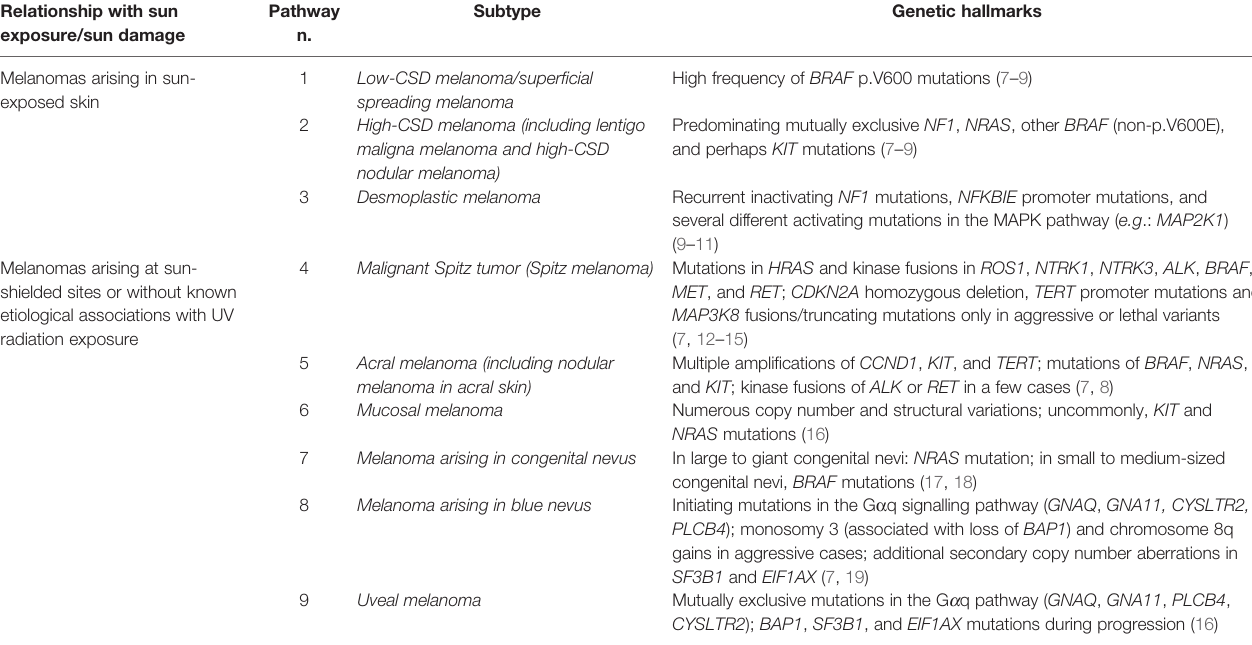
TABLE 2 | The WHO 2018 classi fi cation of melanoma according to pathways. Relationship with sun exposure/sun damage